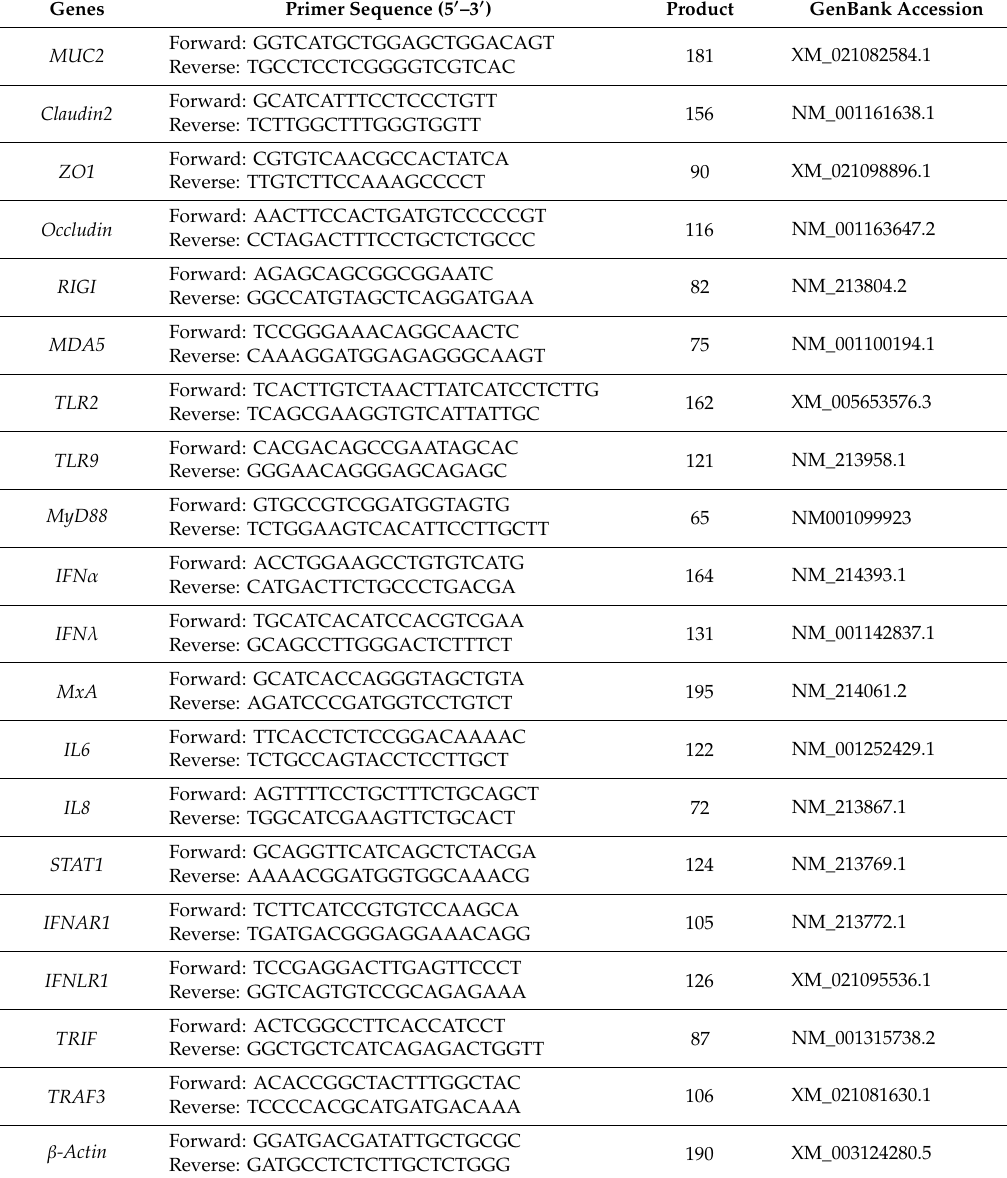
Table 2. Primer sequence of the target and reference